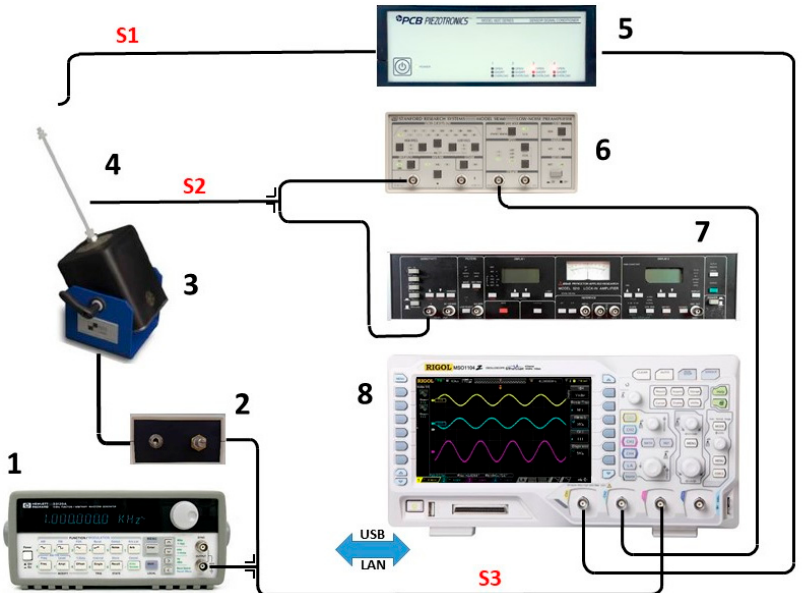
Figure 4. (1) Function generator; (2) audio frequency amplifier; (3) shaker; (4) detector head and sample holder; (5) accelerometer amplifier; (6) low-noise amplifier; (7) lock-in amplifier; (8) oscilloscope. The three signals acquired and processed are: S1 - accelerometer signal from the oscillating head; S2 - piezoelectric signal generated by the cantilever (DUT); S3 - sinusoidal shaker excitation signal with adjustable amplitude and frequency.